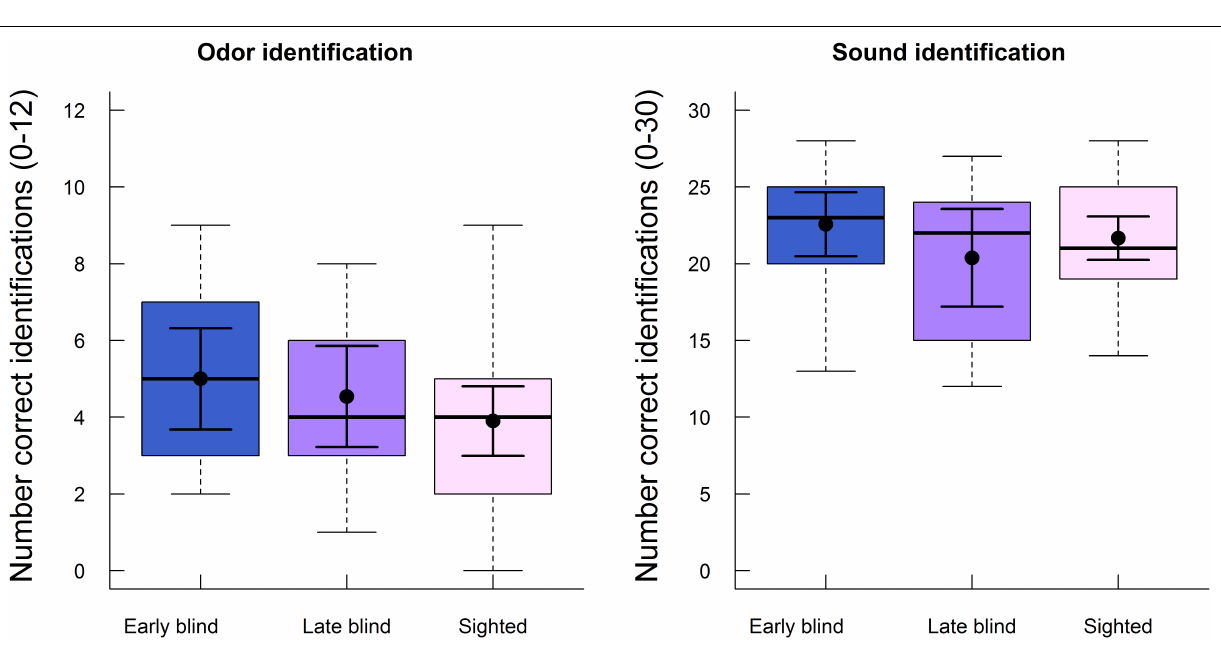
FIGURE 4 | Boxplots of identification performance for high familiar odors (left panel) and high familiar sounds (right panel) at follow-up (T2) are displayed separately for early blind, late blind, and sighted participants. The boxes indicate the 25th, 50th (median), and 75th percentiles of the distribution (lower, middle, and upper horizontal lines of the box). The upper hinges indicate the maximum value of the variable located within a distance of 1.5 times the inter-quartile range above the 75th percentile. The lower hinges indicate the corresponding distance to the 25th percentile value. The means and 95% confidence intervals (dots and error bars in solid lines) are superimposed on the